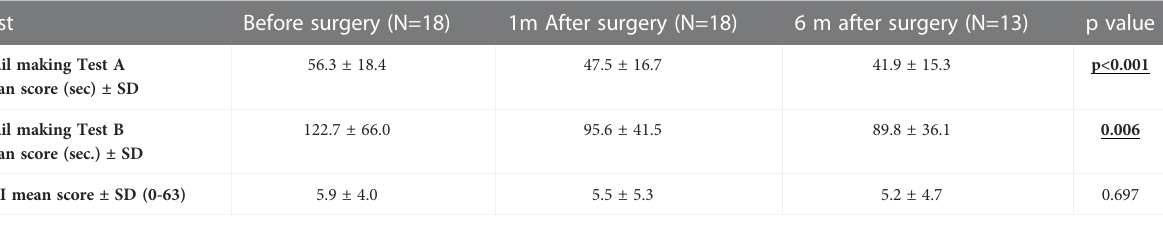
TABLE 3 Mean scores before and after parathyroidectomy, improvement is score descent.